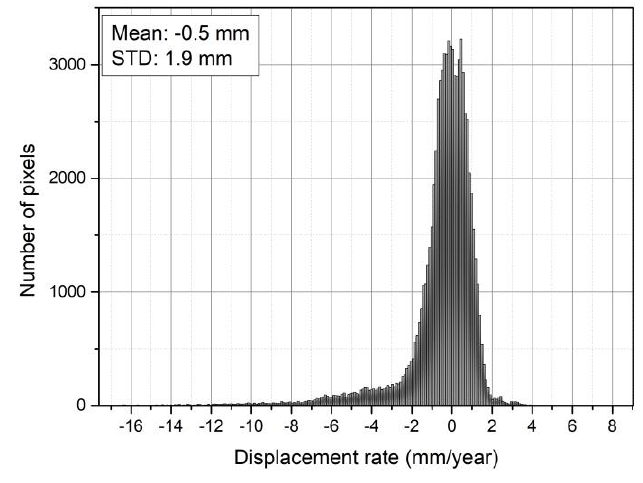
Figure 10. The corresponding histogram of the SBAS measurements from the PALSAR-2 data.